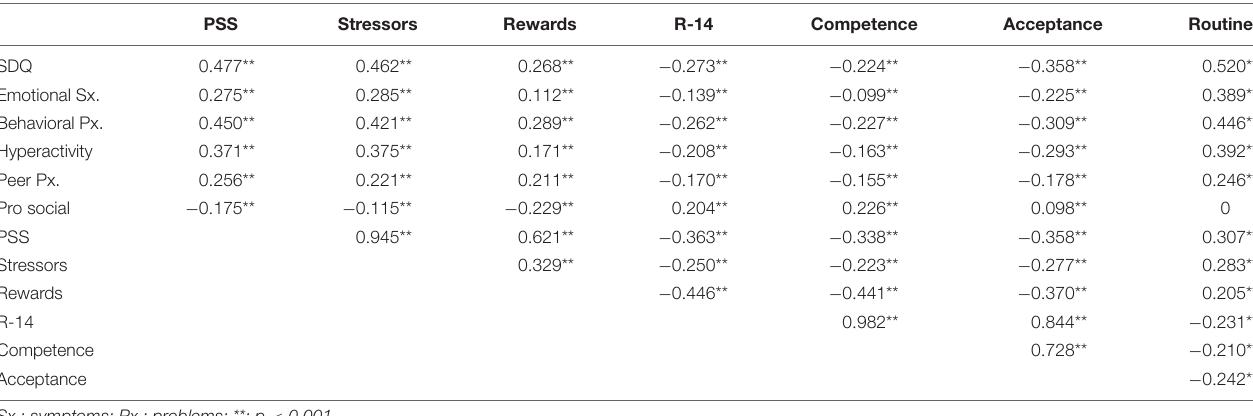
TABLE 4 | Pearson’s bivariate correlations.